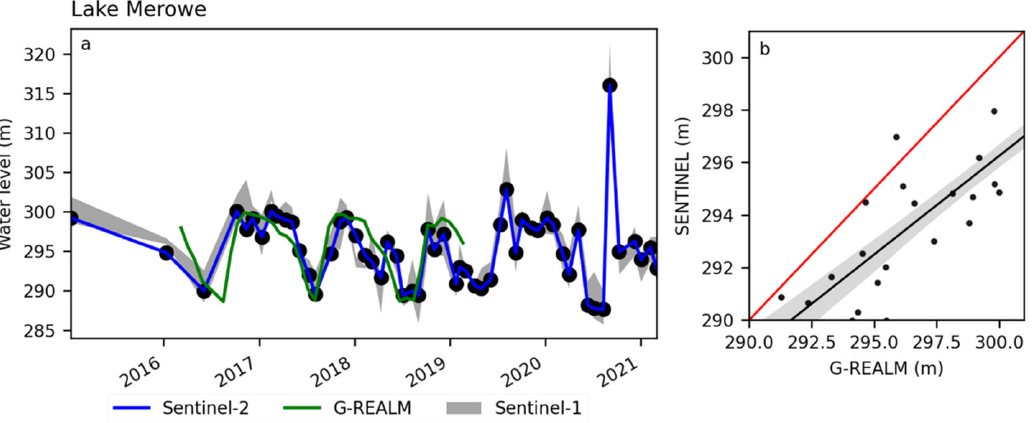
Figure 5. ( a ) Water levels estimated using contour matching from SRTM DEM with surface water extent derived from Sentinel-1, Sentinel-2, and G-REALM for Lake Merowe. The band of values for Sentinel-1 represents the water levels derived from threshold values ranging from − 15 to − 20 dB for the extraction of water masks. ( b ) Scatter plot showing the relationship between water levels estimated from Sentinel vs. G-REALM data.